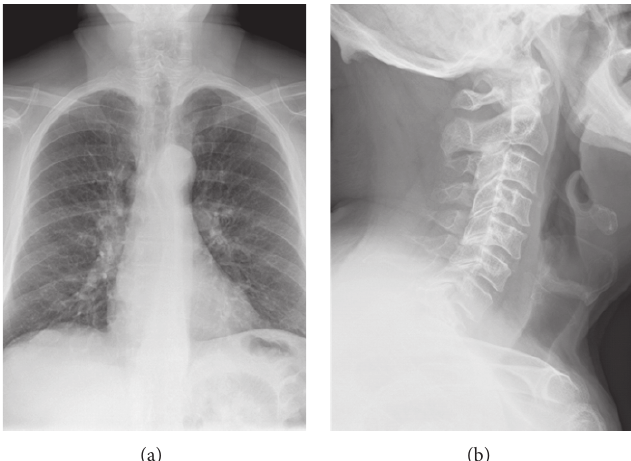
Figure 1: PA chest (a) and lateral neck (b) radiographs obtained day of suspected aluminum tab aspiration fail to demonstrate a metallic foreign body. There is no evidence for supportive findings on chest radiographs such as atelectasis or air-trapping.